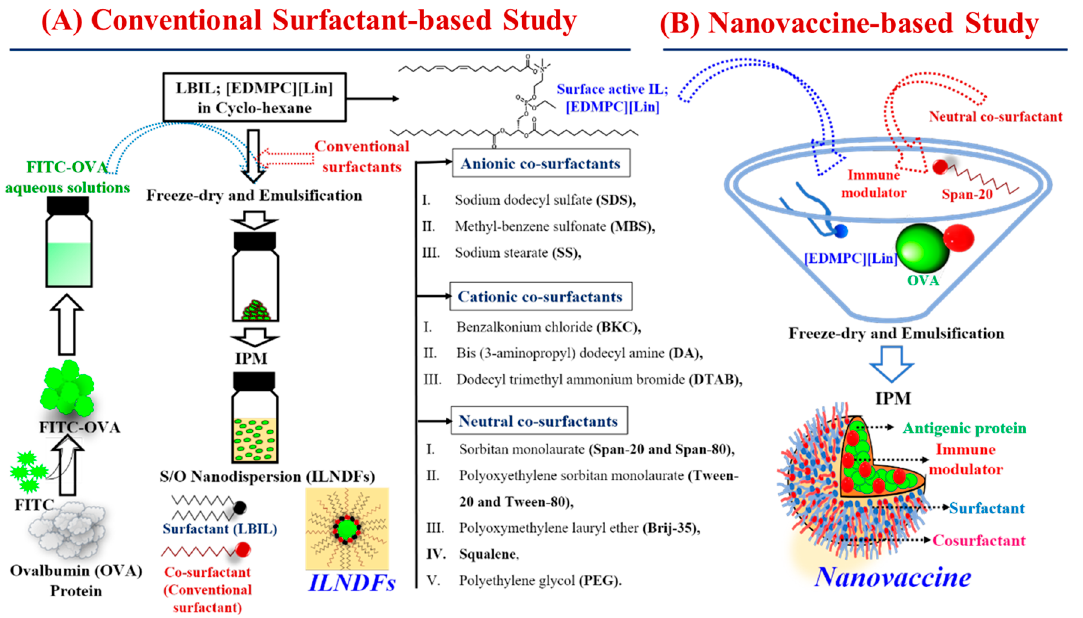
Figure 1. Schematically represented synthesis pathways of ( A ) ILNDFs and ( B ) IL-associated protein- and immunomodulator-containing nanoparticles for vaccination (nanovaccine). The hydrophobic tails and hydrophilic heads of nonionic surfactants allow drug molecules to dissolve in the oil phase, thereby improving stability and biocompatibility. Furthermore, cationic and anionic surfactants carry positive and negative charges in a medium, respectively, causing damage to the cell membrane or a toxic effect and resulting in reduced cell viability. The safety of a new surfactant must be demonstrated in nonclinical and clinical studies according to U.S. FDA guidelines, especially when dealing with pharmaceutical formulations [35]. No-ionic ILNDFs were associated with greater cell viability in skin irritation tests using the LabCyte EPI model cell line, whereas both cationic and anionic ILNDFs had toxic effects. Cell viability was significantly reduced ( p < 0.01) when PBS solutions were compared with BKC-, DA-, SS-, Brij-35–, DTAB-, SDS-, and MBS-based ILNDFs; however, S-20-, S-80-, T-20-, T-80-, squalene-, and PEG-based ILNDFs were biocompatible (Figure 2C).